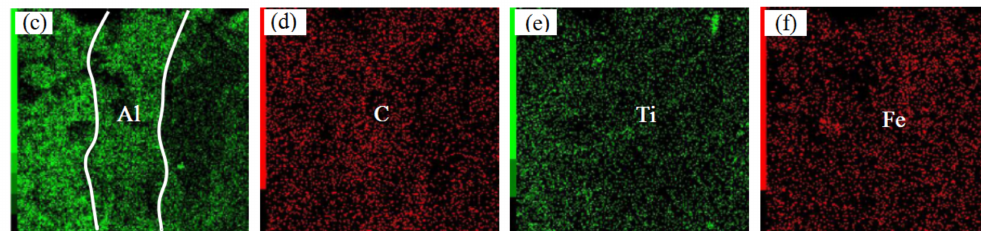
Figure 6. The surface SEM images ( a ) and EDS analysis result ( b ) and element content of Plane scan (( c ) Al content ( d ) C content ( e ) Ti content ( f ) Fe content) of Coating I.